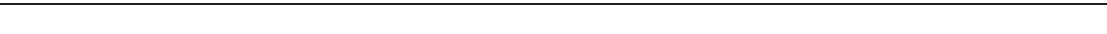
Fig. 5 Lateral Actomyosin enrichment precedes basal actomyosin clearing. a Representative image sequence of a wild-type neuroblast expressing Sqh:: mCherry (Myosin), LifeAct::GFP (Actin) and the Myosin activity FRET sensor. Curvature is determined for each pixel along the yellow line (4th row). Ingression occurs when curvature changes from “ − “ to “ + ” . The region corresponding to the future cleavage furrow is indicated in red and plotted in the graphs below (grey line). Blue arrows emphasize furrowing. b Plot of a representative neuroblast showing Myosin (green line) and Actin (red line) intensity changes in the prospective furrow region, in relation to curvature changes. For this and subsequent plots, curves were smoothened (dashed black line with black triangles) and plotted in the same graph. The time difference between an increase in Myosin and Actin intensity in the prospective furrow region and furrowing (dashed lines and green and red arrows, respectively), was extracted from the smoothened curves and plotted in ( c ). d Plot showing changes in FRET ratios in the prospective furrow region in relation to furrowing. The time difference between the onset of FRET ratio increases and furrowing (dashed blue lines and blue arrows, respectively) are shown in e . f Actin (purple line) and Myosin (orange line) intensity changes were plotted for the basal cortex. The time difference between actomyosin intensity drops and furrowing (dashed lines and purple and orange arrows, respectively) were plotted in g . Asterisks denote statistical signi fi cance, derived from unpaired t tests: * p ≤ 0.05, ** p ≤ 0.01, *** p ≤ 0.001, **** p ≤ 0.0001. Each measured cell (n) is represented with a dot in the scatter plots. For each experiment, the data were collected from at least 3 independent experiments. For each independent experiment, at least 5 larvae were dissected. Time: seconds (s). Scale bars: 5 µ m. n.s. not signi fi